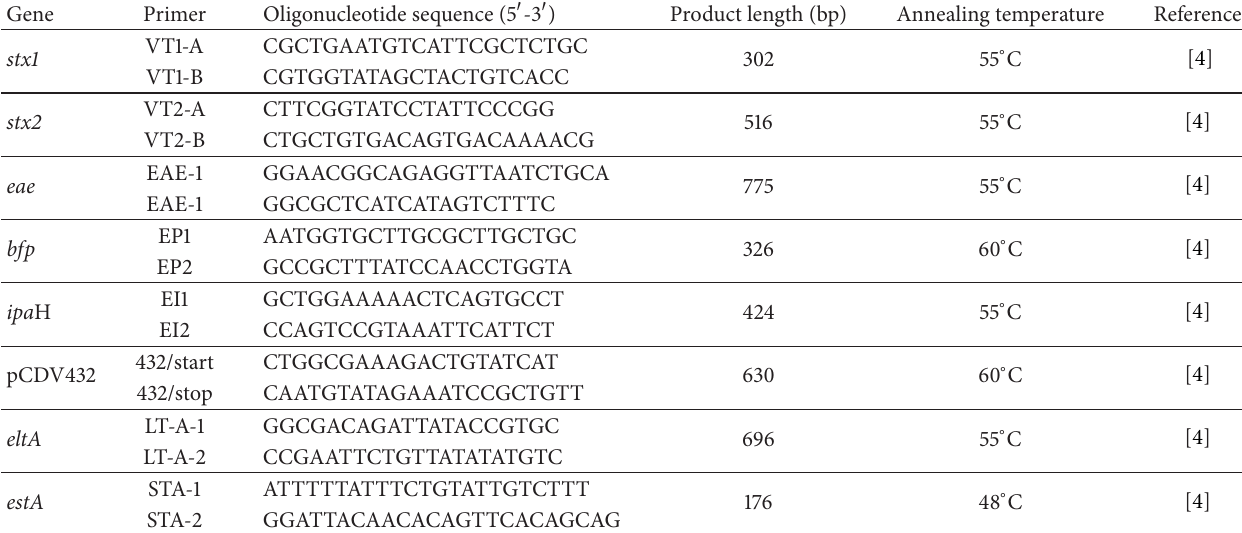
Table 1: Primers used for amplifying genes of